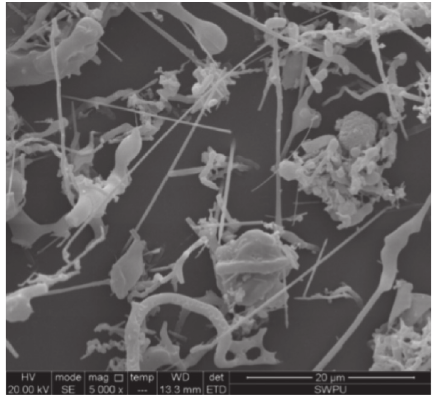
Figure 1: Microstructure of SiC whiskers.